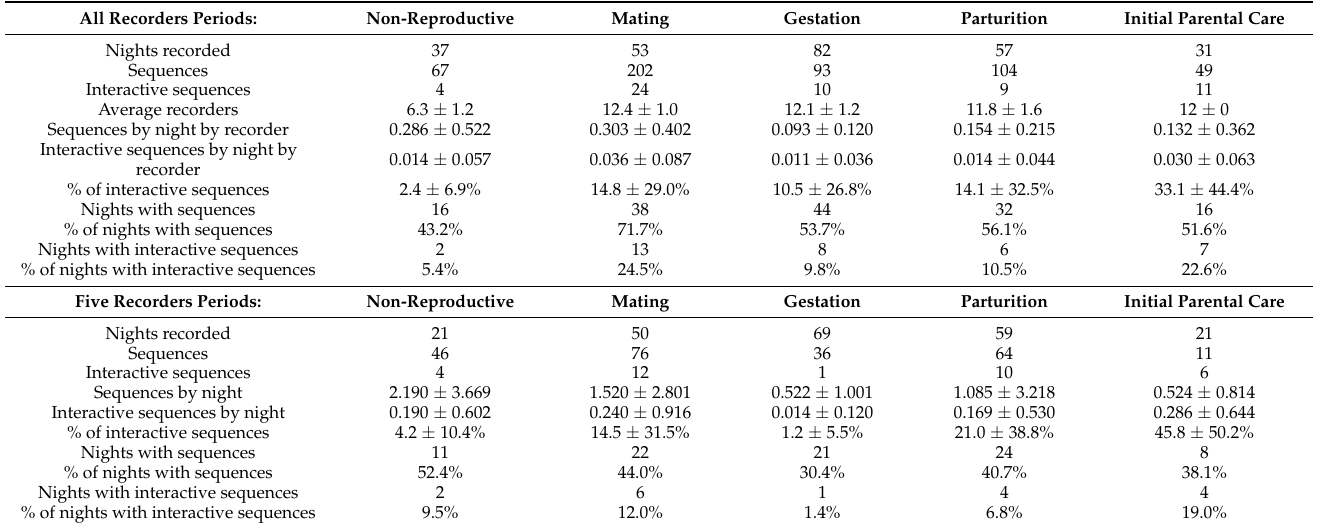
Table 1. Maned wolves’ roar-bark sequences recorded passively at the Serra da Canastra National Park. At the top is the complete dataset (all recorders) and at the bottom the subsample of the 5 common recording sites used in all periods (only nights in which all 5 were